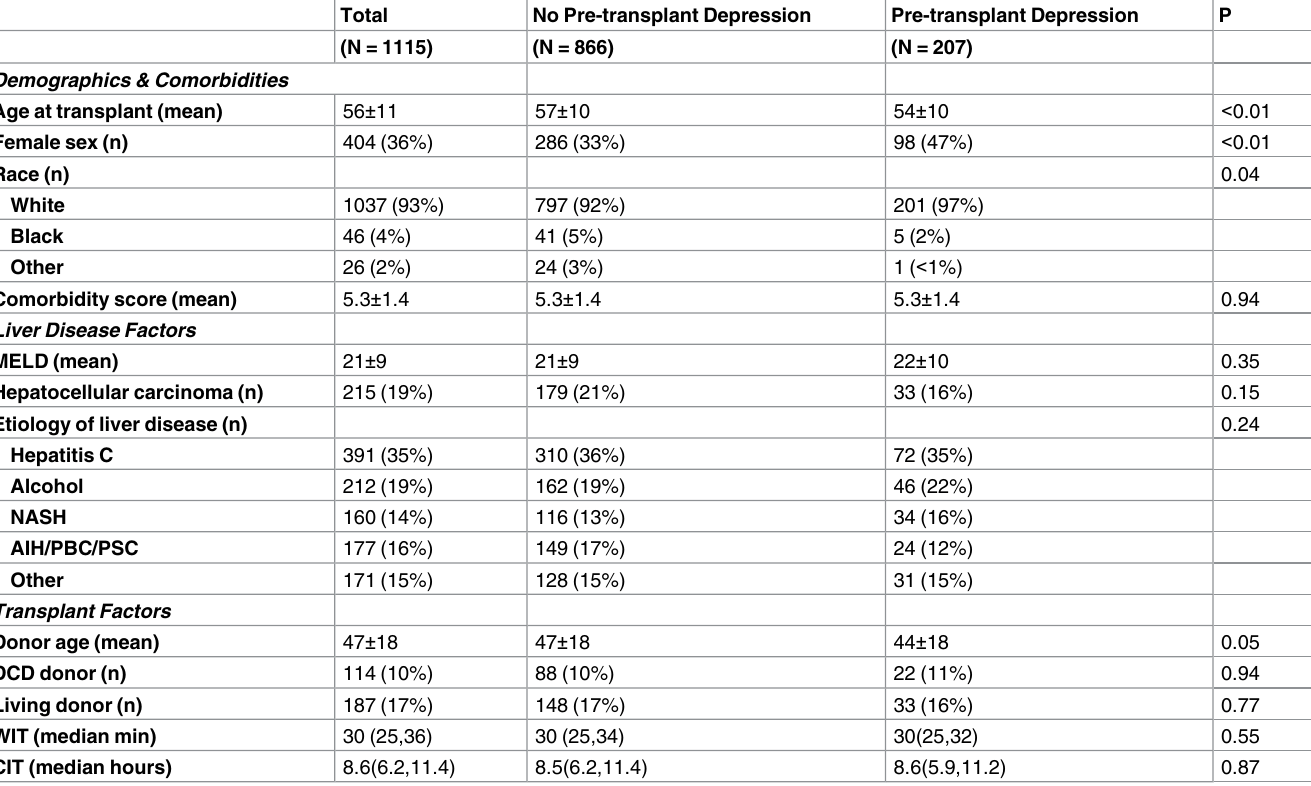
Table 1. Patient Characteristics for the Cohort and by Depression